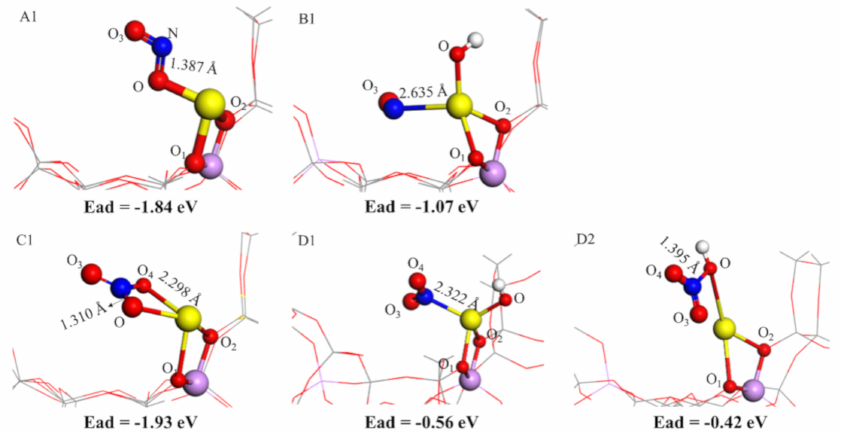
Figure 6. Structures of NO adsorption on Lewis and Brønsted acid sites of In / BEA: NO on In and O site of L-model ( A1 ); NO on In and O site of B-model ( B1 ); NO 2 on In and O site of L-model ( C1 ); NO 2 on In site of B-model ( D1 ); NO 2 on O site of B-model ( D2